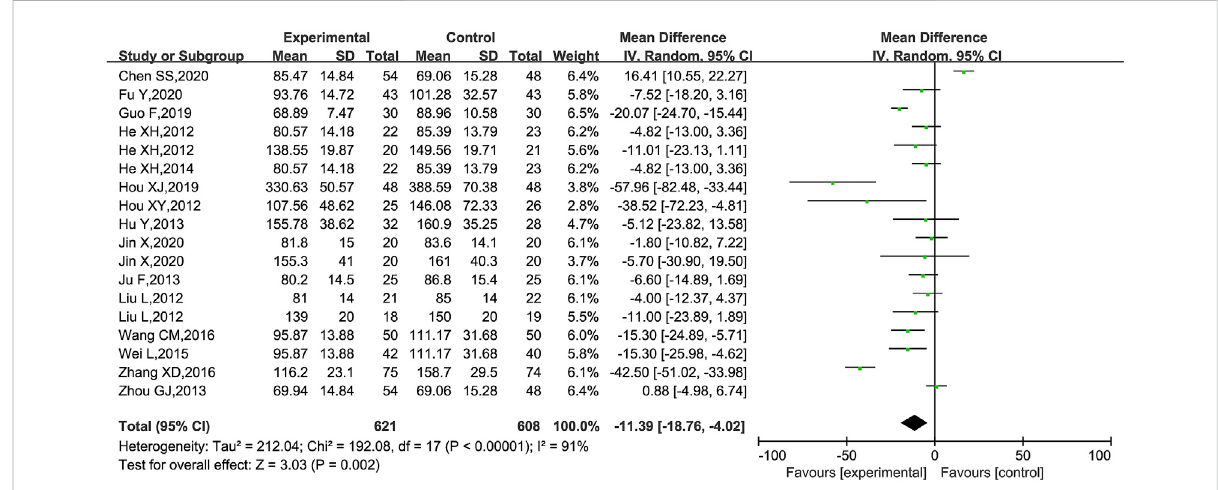
FIGURE 7 Forest plot of Scr for KLXC + Western medicine vs. Western medicine alone ( μ mol/L).